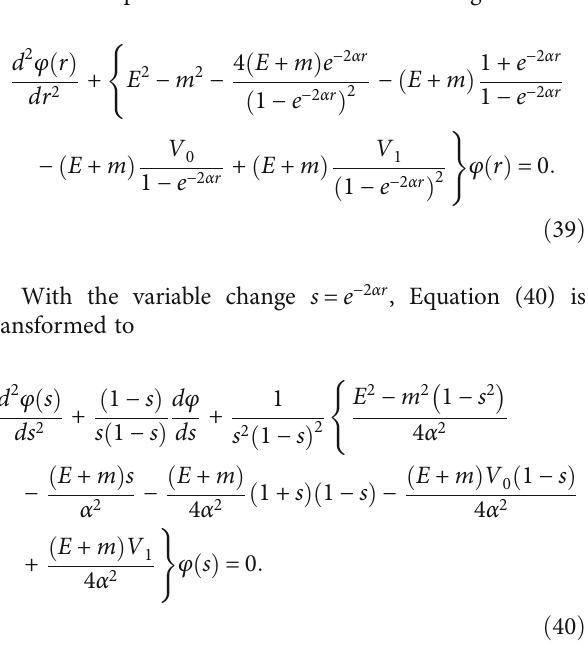
n = l = 0 ) in atomic units y = μ = 1 2 diatomic molecule (